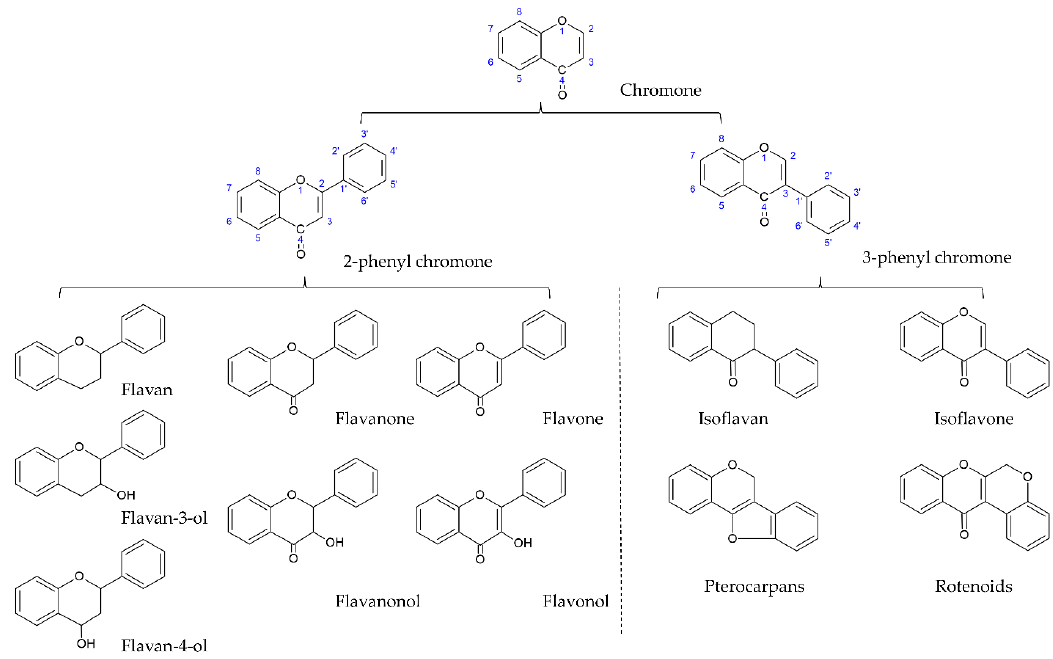
Figure 1. Core structures of flavonoids and isoflavonoids.